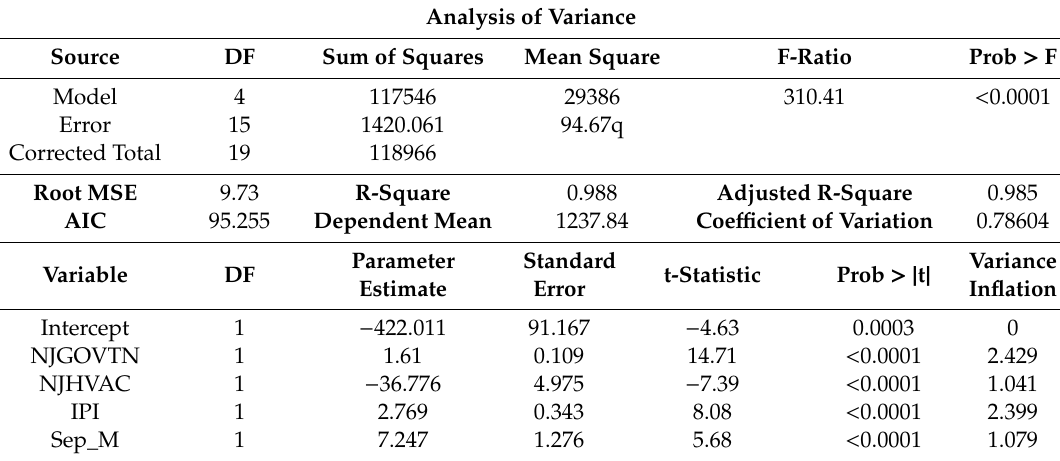
Table 1. The results for the regression model for annual